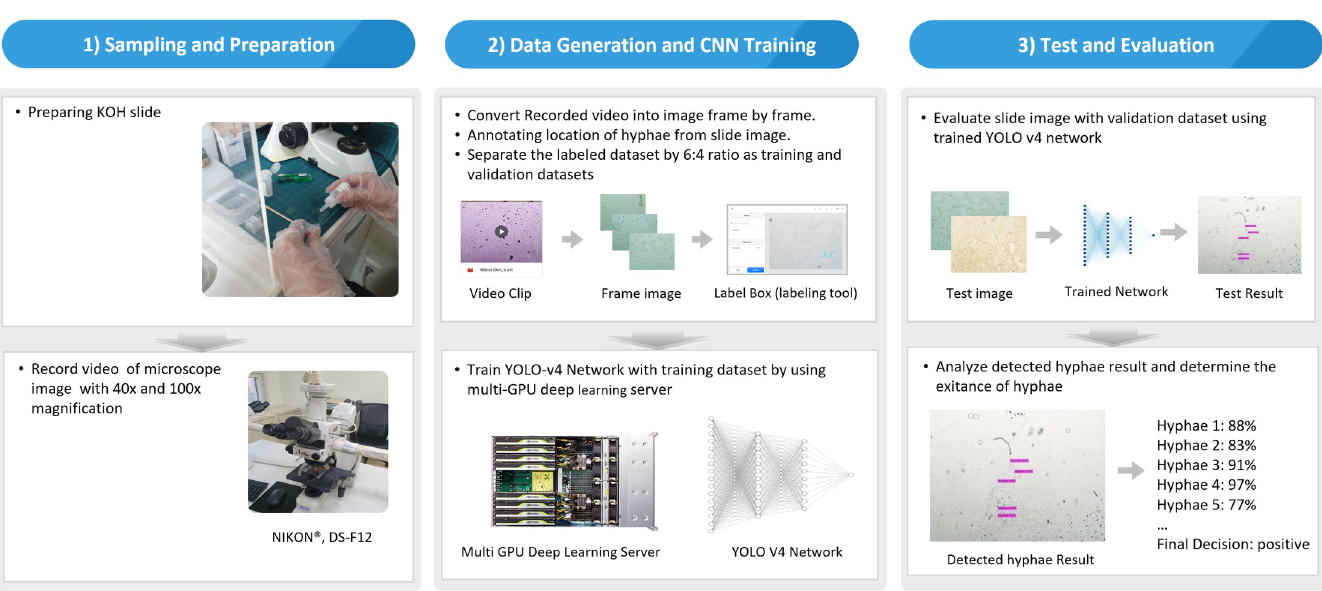
Fig 1. Workflow for developing a deep learning-based autodetection model that detect hyphae in microscopic images obtained from real-world practice.